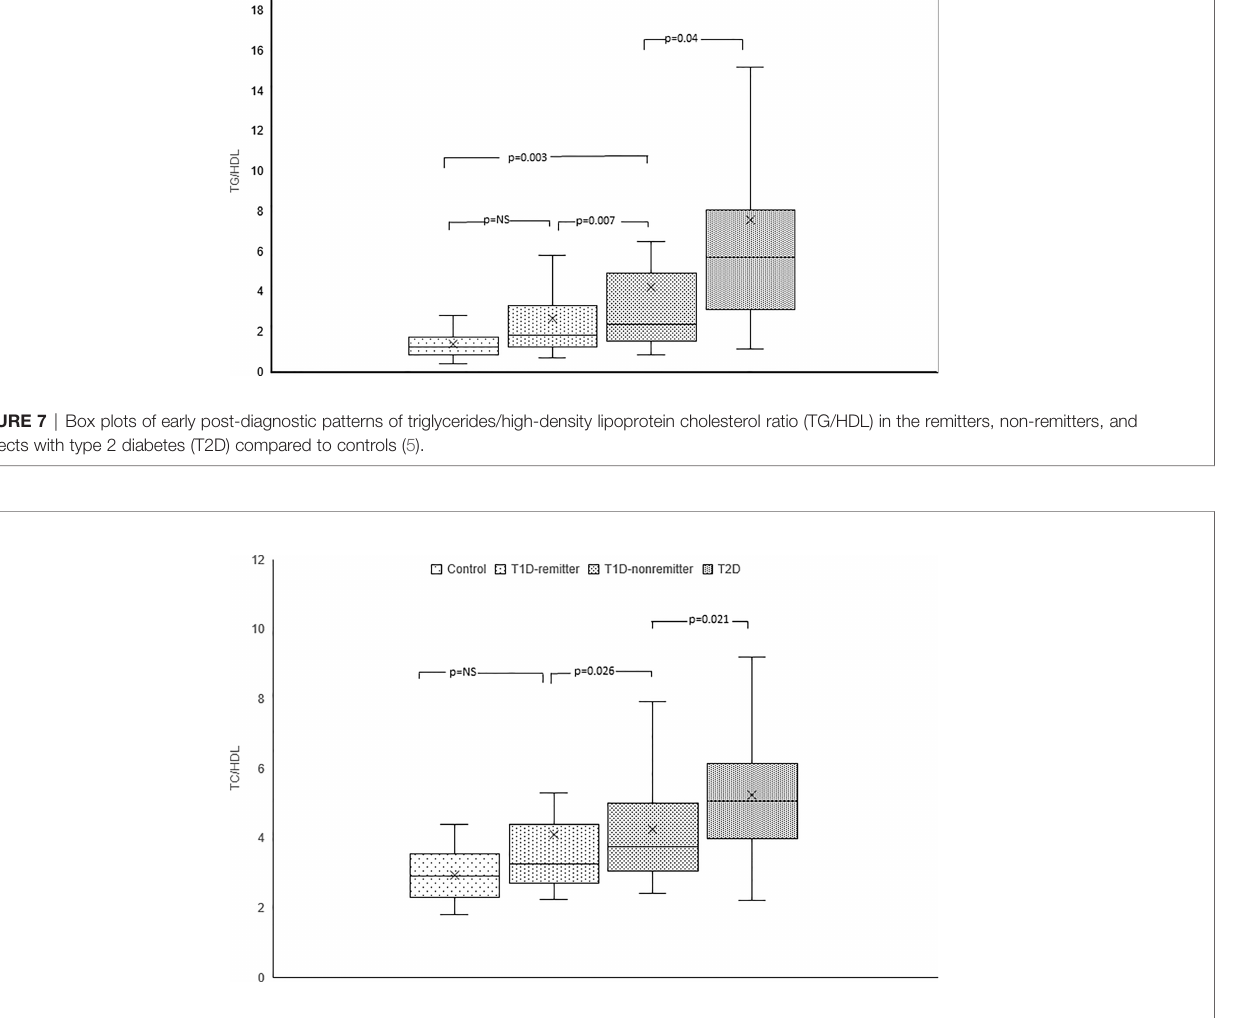
FIGURE 8 | Box plots of early post-diagnostic patterns of total cholesterol/high-density lipoprotein cholesterol ratio (TC/HDL) in the remitters, non-remitters, and subjects with type 2 diabetes (T2D) compared to controls (5).